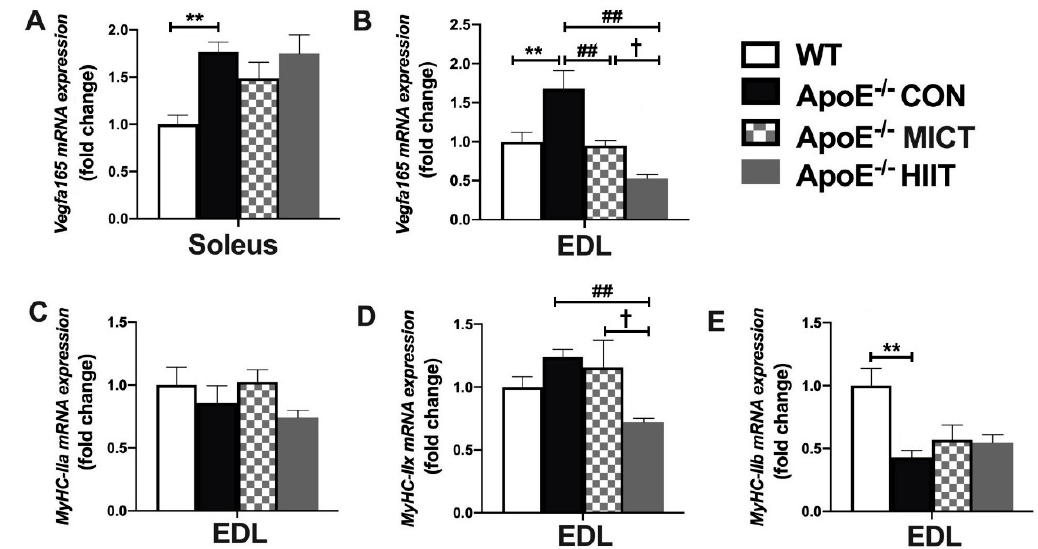
Figure 2. Effects of HIIT and MICT on the mRNA expression of Vegfa165 in soleus ( A ) and EDL ( B ), and MyHC-IIa , MyHC-IIx , and MyHC-IIb in EDL ( C – E ) of WT and ApoE KO mice on HFD. Values are displayed as the mean ± SEM (n = 10/group). ** p < 0.01 vs. WT; ## p < 0.01 vs. ApoE − / − CON; † p < 0.05 vs. ApoE − / − MICT.